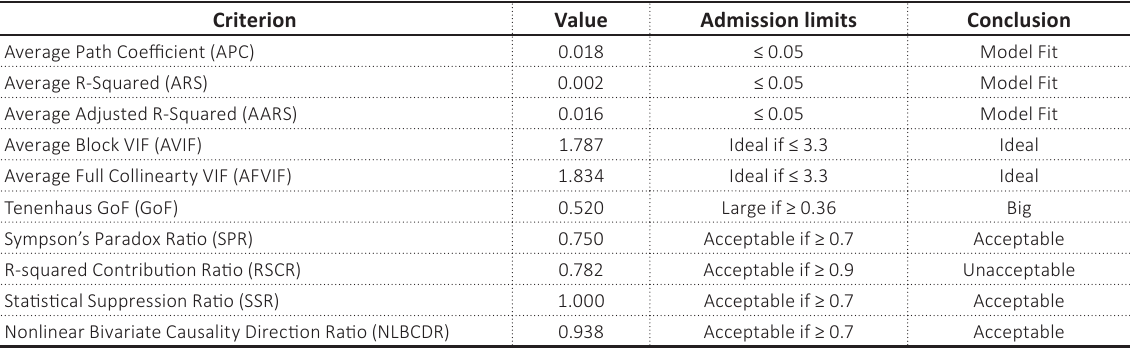
Table 2. Model fit and quality indices